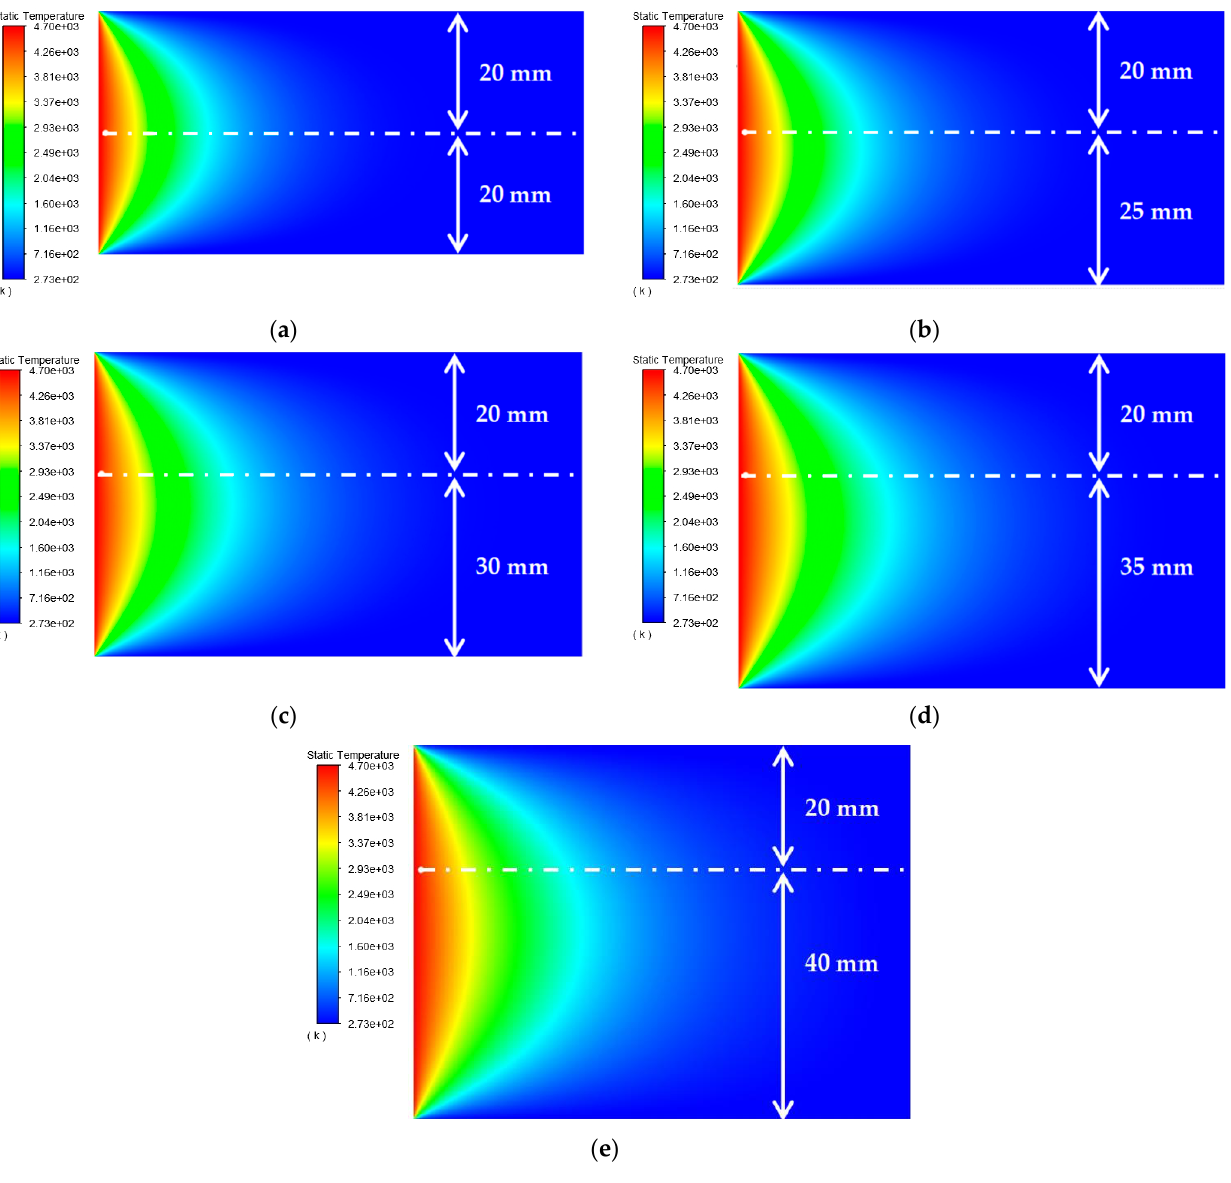
Figure 6. Surface temperature distribution diagram of platinum rhodium bushing: ( a ) c 2 = 20 mm; ( b ) c 2 = 25 mm; ( c ) c 2 = 30 mm; ( d ) c 2 = 35 mm; ( e ) c 2 = 30 mm.